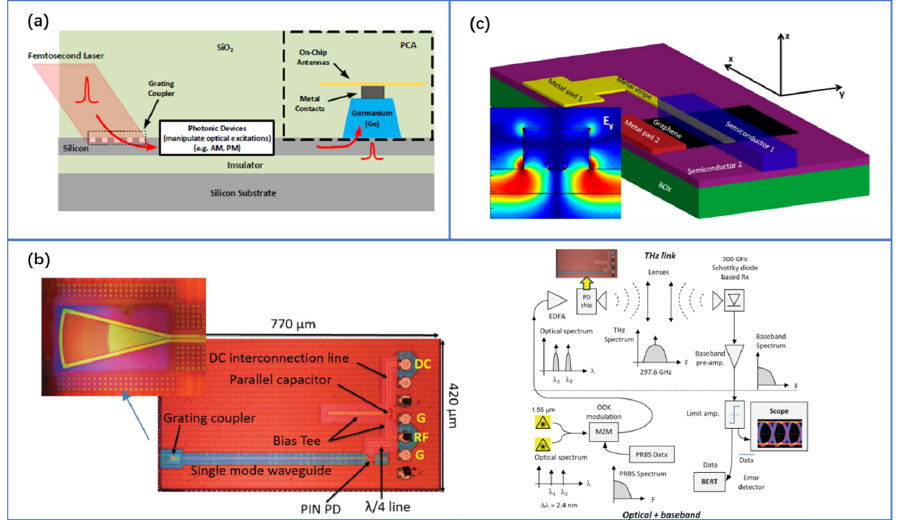
Figure 7. ( a ) Conceptual illustration of a waveguide-coupled THz photoconductive switch integrated on the SOI platform. Reproduced with permission from [97], Copyright, MDPI, 2019. ( b ) 220–330-GHz SiGe PD test structure and experimental setup for THz communication link. © 2012 IEEE. Reprinted, with permission, from [63]. ( c ) Schematic of the graphene photodetector with a 500 GHz bandwidth. Reprinted with permission from [109]. Copyright, American Chemical Society, 2020.